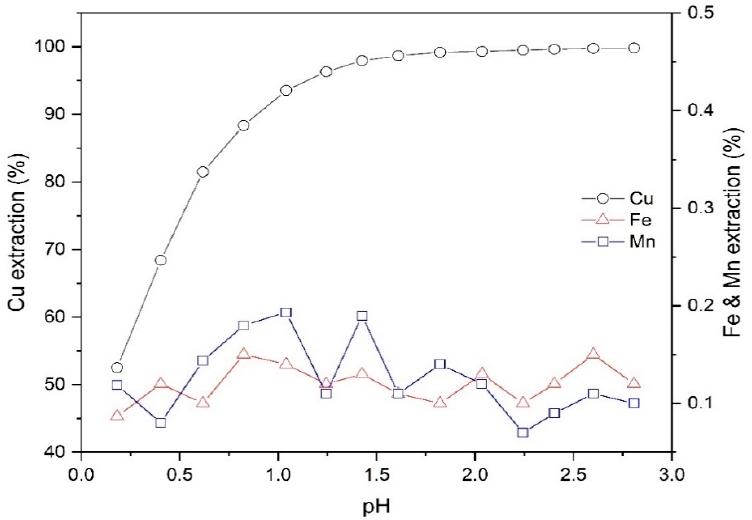
Figure 3. The effect of pH on the extraction of Cu, Fe and Mn (Mextral 5640H = 10% ( v / v ), T = 25 °C, O/A = 1 and t = 30 min).